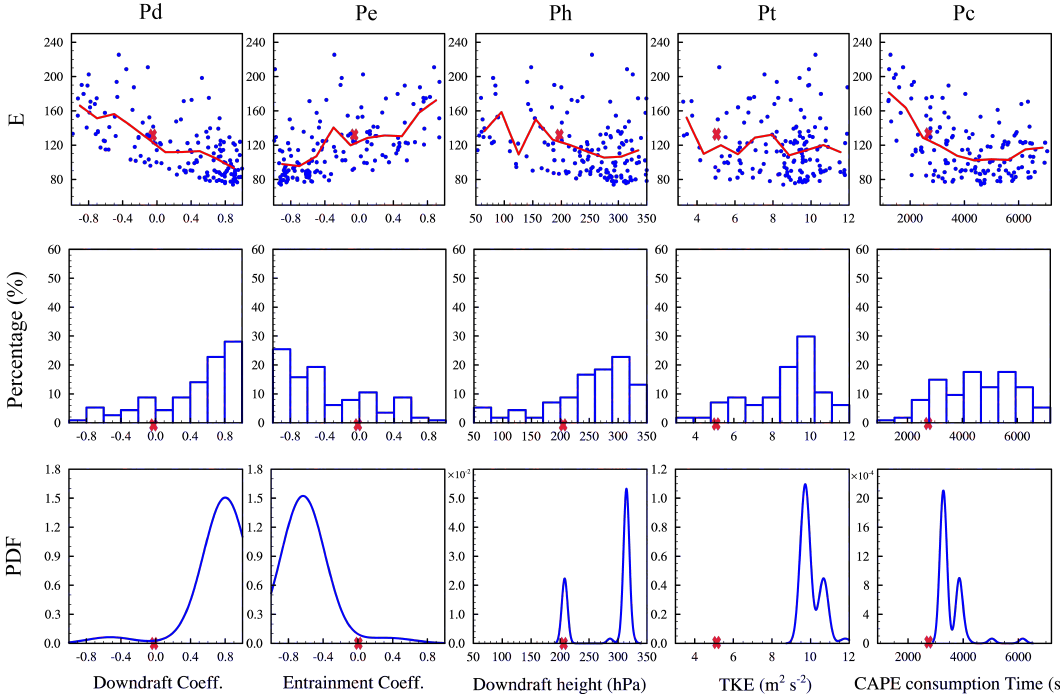
Fig. 4. (Top) The response of model performance (quantified as E as introduced in Sect. 2.2) to five input parameters based on the 148 simulations (25km) over SGP through the MVFSA procedure. Red curves represent an average of results at each bin. Default number of each parameter is marked as red crosses. (Middle) The frequency distributions of “good” experiments as a function of each parameter. “Good” experiments are defined as those with lower E (better performance) than that using the standard KF scheme with default parameters. (Bottom) The marginal probability density functions (PDF) for the five input parameters derived by kernel density estimation.